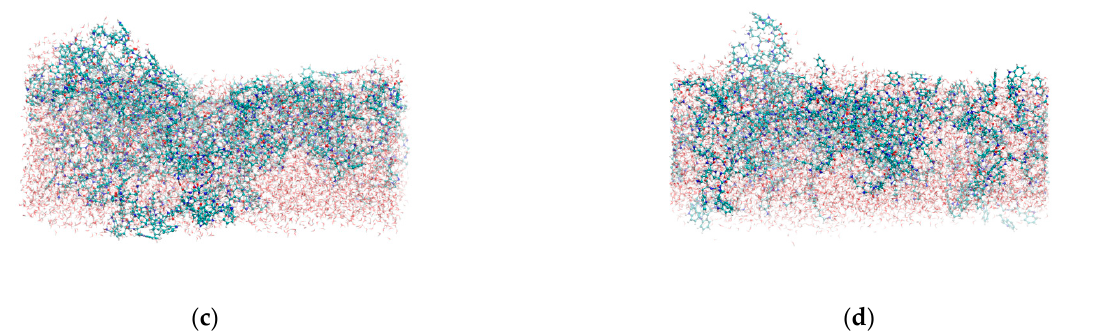
Figure 10. The structures of the peptide-water thin layers after the MD simulations. Peptide P2 system ( a ), P4 ( b ), P5 ( c ) and P6 ( d ).